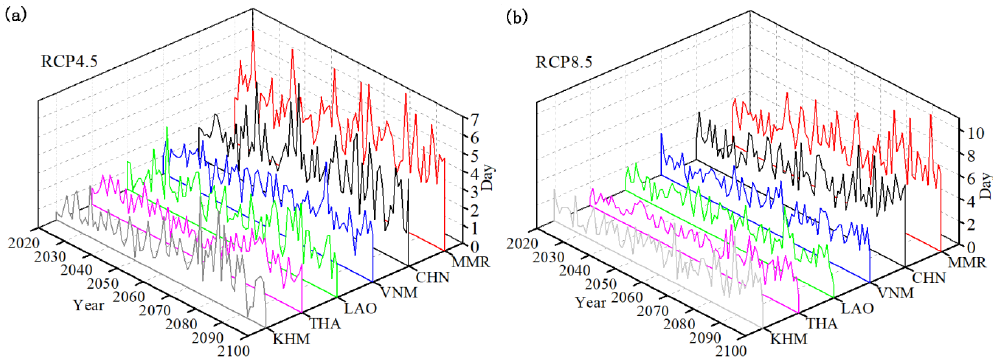
Figure 11. Variation of the number of days with extreme precipitation in the Lancang-Mekong sub-region under the RCP4.5 ( a ) and the RCP8.5 ( b ). Table 2. Trends in the precipitation extremes indices.